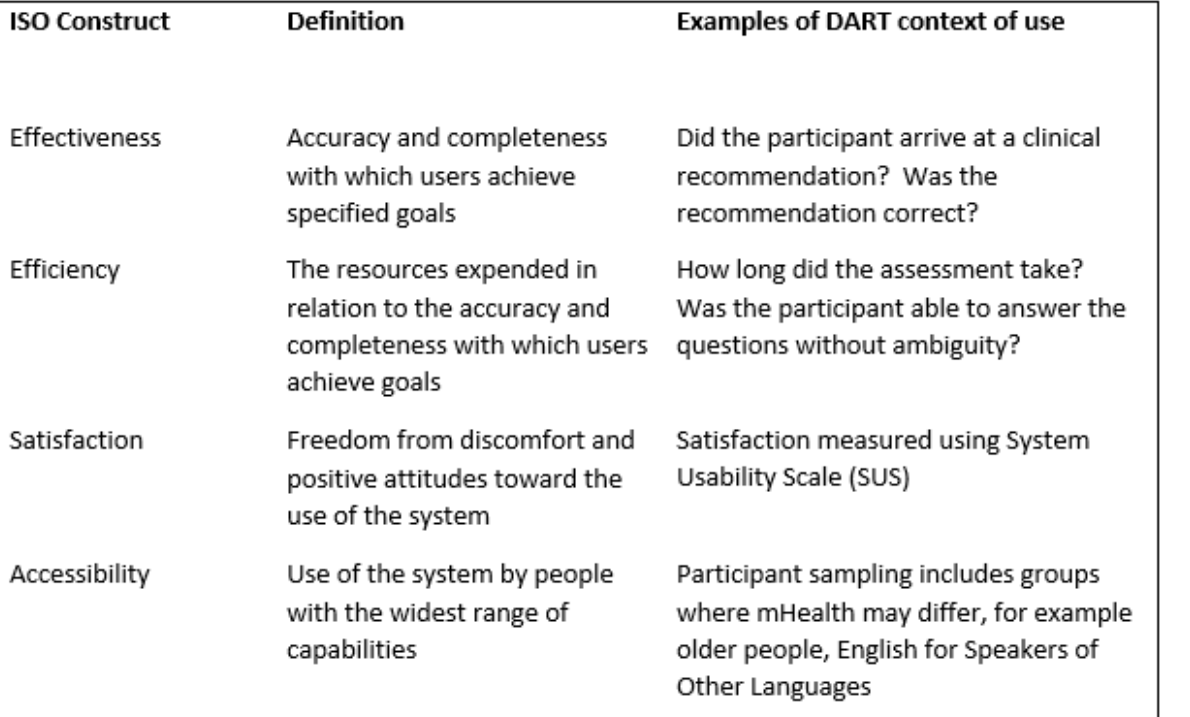
Figure 1. ISO 9241-210:2019 constructs and definitions and examples of digital assessment routing tool context of use. DART: Digital Assessment Routing Tool; mHealth: mobile